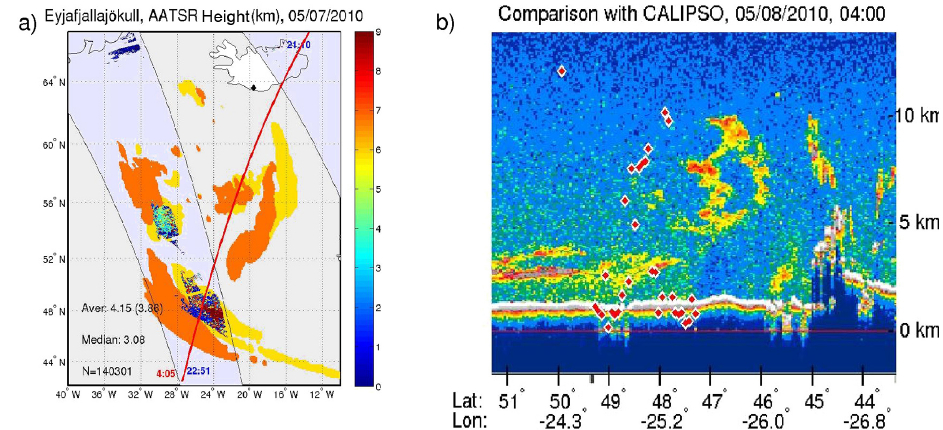
Figure 12. Eyjafjallajökull eruption, 7–8 May 2010; a near-simultaneous overpass of AATSR and CALIPSO over a large ash cloud. (a) The shaded blue area shows the AATSR swath on 7 May at approximately 22:51, while the red line shows the CALIPSO track on 8 May at approximately 04:05. The color-coded pixels show the ACM height estimate. The yellow area shows ash plume detected by SEVIRI on 7 May at 23:00, which coincides with the ACM plume (within the AATSR swath). The orange area shows the plume observed by SEVIRI 5h later, at the time of CALIPSO overpass. (b) CALIOP backscatter profile on 8 May at 04:00, with the ACM height estimates from 7 May 22:51 shown by the red symbols. The ash plume is seen between 46 and 48 ◦ N in the back scatter data, while for ACM it was observed near 48–49 ◦ N.